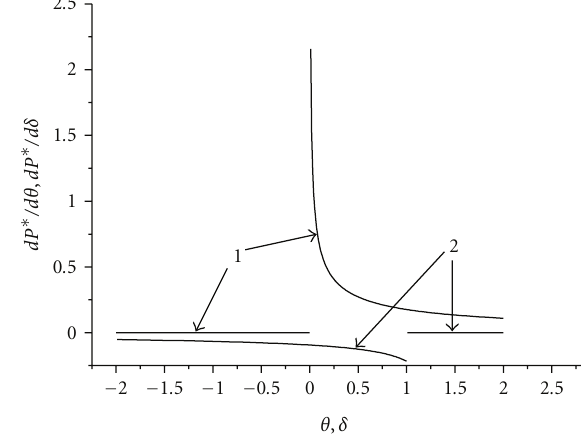
Figure 8: Dependence of the pyroelectric coe ffi cient on the dimen- sionless temperature for systems undergoing first- and second- order phase transitions. The curve 1 describes the behavior of the pyroelectric coe ffi cient for the second-order phase transition. There is a singularity in the vicinity of θ = 0 of the order of 1 / 2. The pyroelectric coe ffi cient for systems with the first-order phase transition is described by curve 2. There is a discontinuity of the dependence ( dP ∗ /dδ )( δ ) in the vicinity of δ = 1.